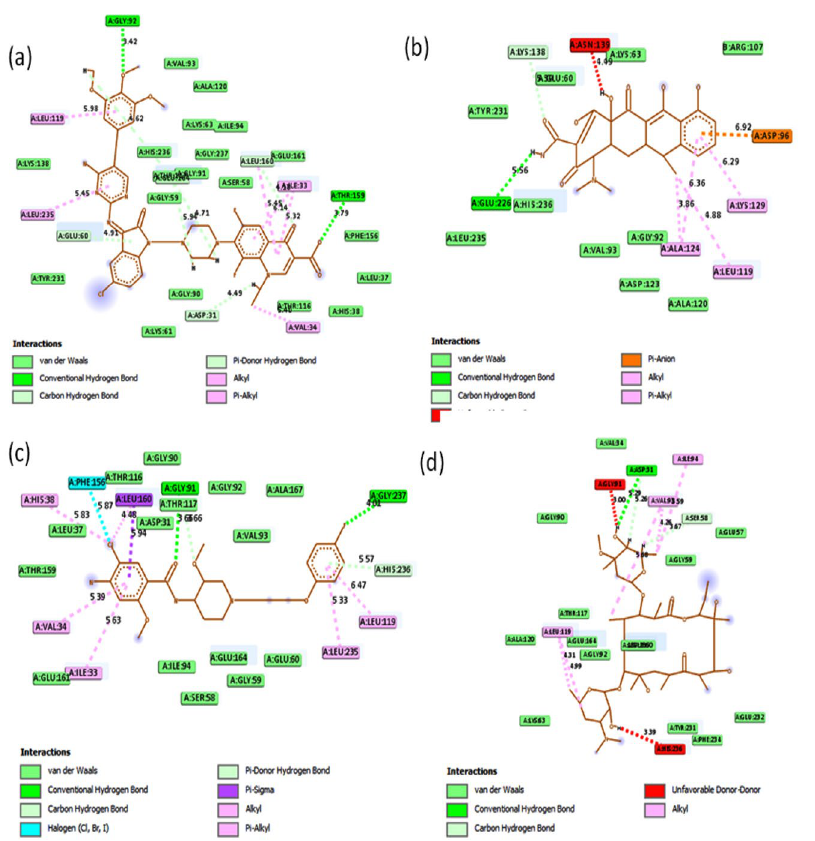
Fig. 2A. 2D interactions of compounds FLRQ, TET,CSP and ETM with chorismate synthase PDB: 1UFM. 2D structures of the candidate drugs (a) Fluoroquinolone (FLRQ). (b) Tetracycline (TET). (c) Cisapride(CSP). (d) Erythromycin